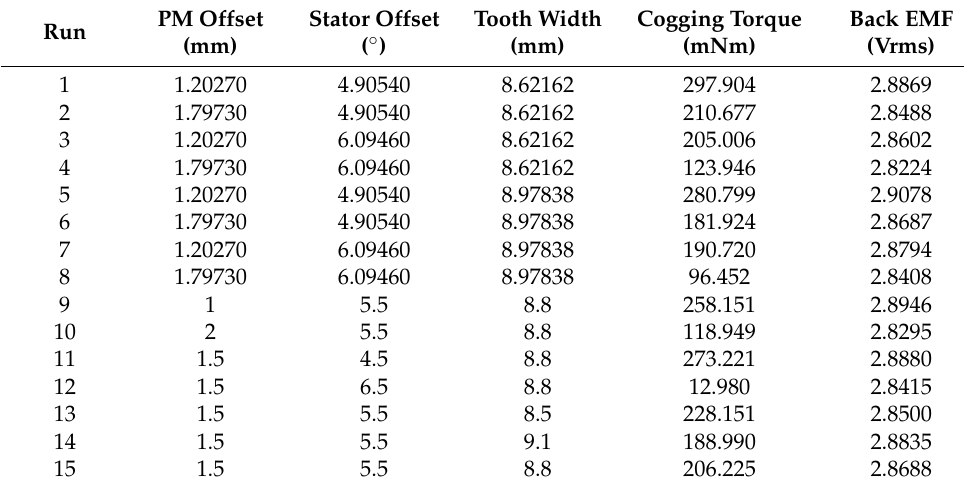
Table 2. Design variables and responses of the